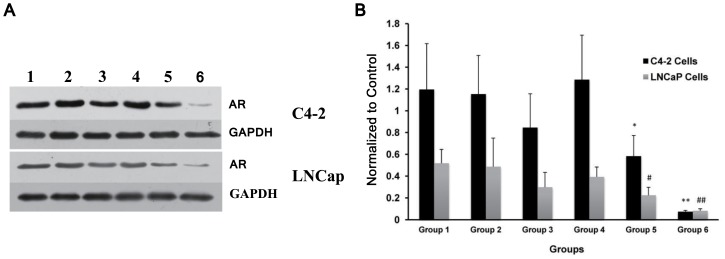
Western blot results of AR protein expression in C4-2 and LNCaP cells.Lanes 1–6 represent Groups 1–6, respectively (Group1: siRNA+NB, Group2: siRNA-NB, Group3: siRNA+US, Group4: NB+US, Group5: siRNA+NB+US, Group6: siRNA-NB+US). GAPDH protein served as an internal reference. The highest suppression was observed in Group 6. (A) and (B): Immuno-bands and the results of image quantification; the data in the histograms represent the means ± SD of five independent experiments. (* P<0.05 and ** P<0.01 vs. Group 1 C4-2 cells; # P<0.05 and ## P<0.01 vs. Group 1 LNCaP cells).